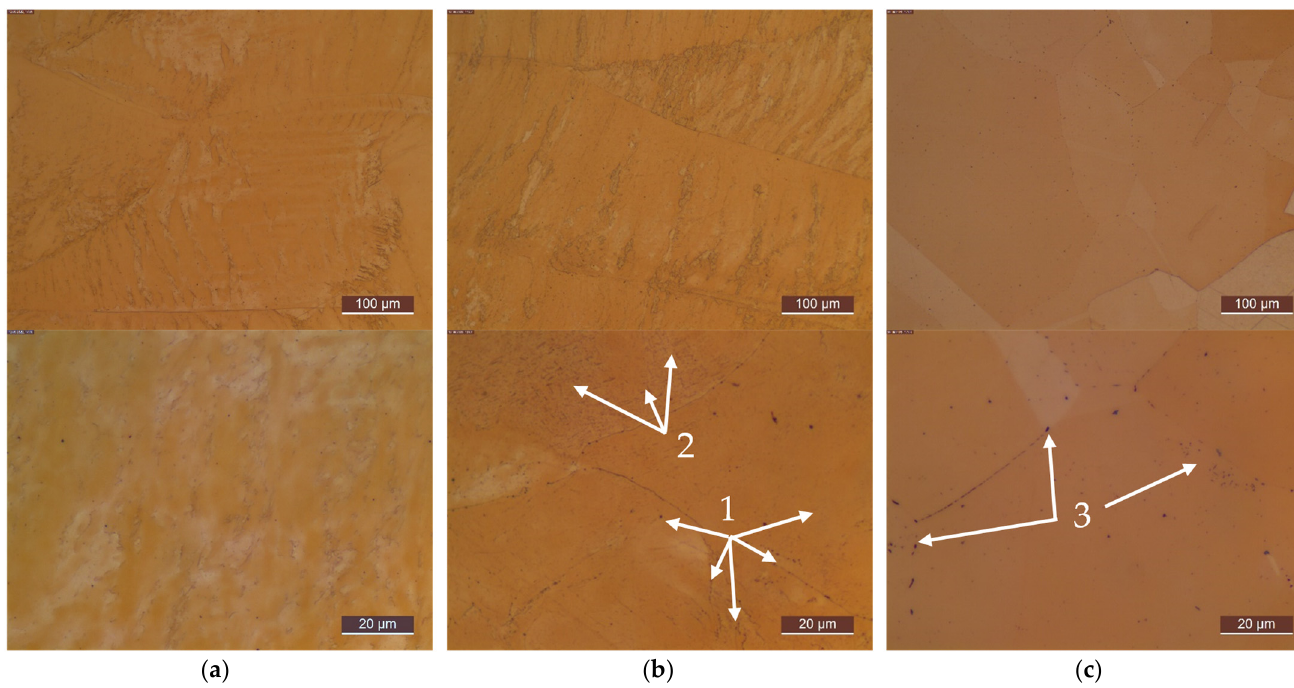
Figure A8. Microstructure evolution of CuSc0.3 during DSC measurements in the optical microscope: specimen with prior cold rolling; ( a ) initial state after 75% cold deformation; and after DSC measurement; ( b ) condition 1; ( c ) condition 2; showing fine precipitates located on slip bands next to dislocations (1), larger lamellar precipitates (2), and coarsened scandium precipitates (3).